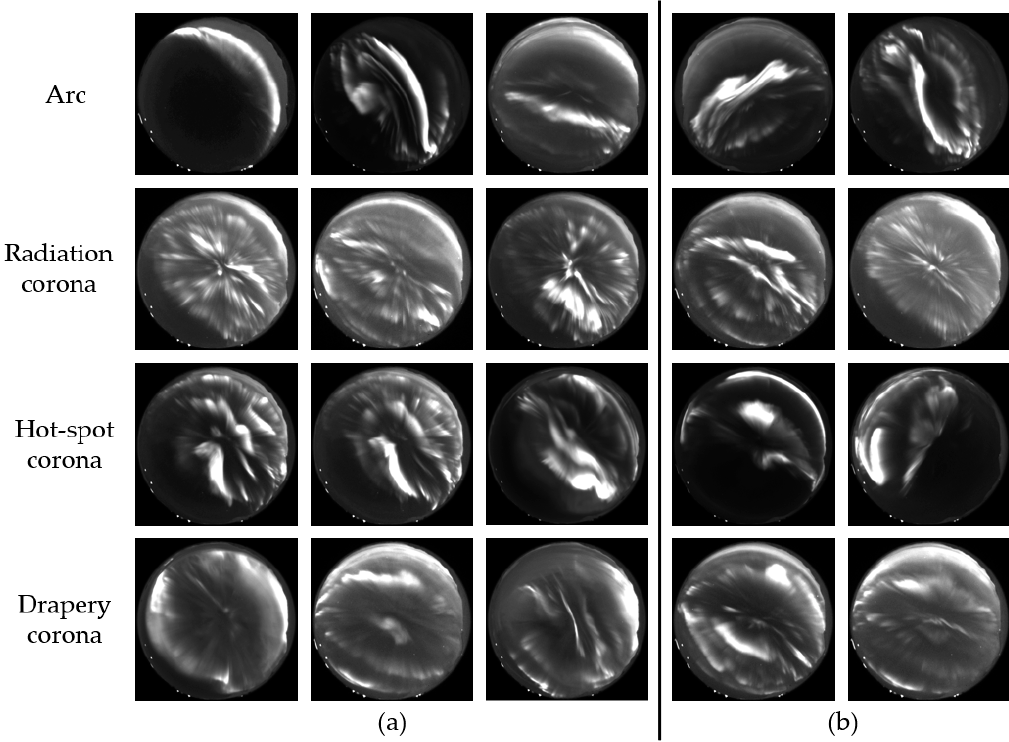
Figure 9. Some of the classification results of the different methods. The four rows correspond to the four classes of aurora image. ( a ) Correctly classified images for all the methods. ( b ) Images classified correctly by AI-MFLDA, but incorrectly classified by the other